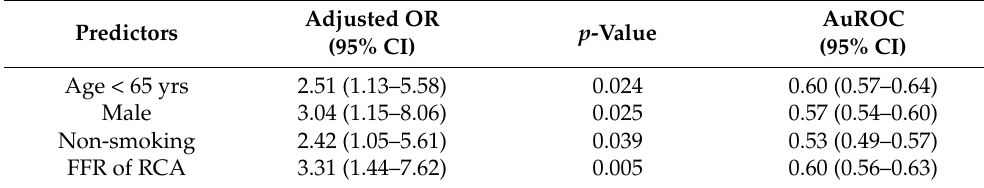
FFR—fractional flow reserve; RCA—right coronary